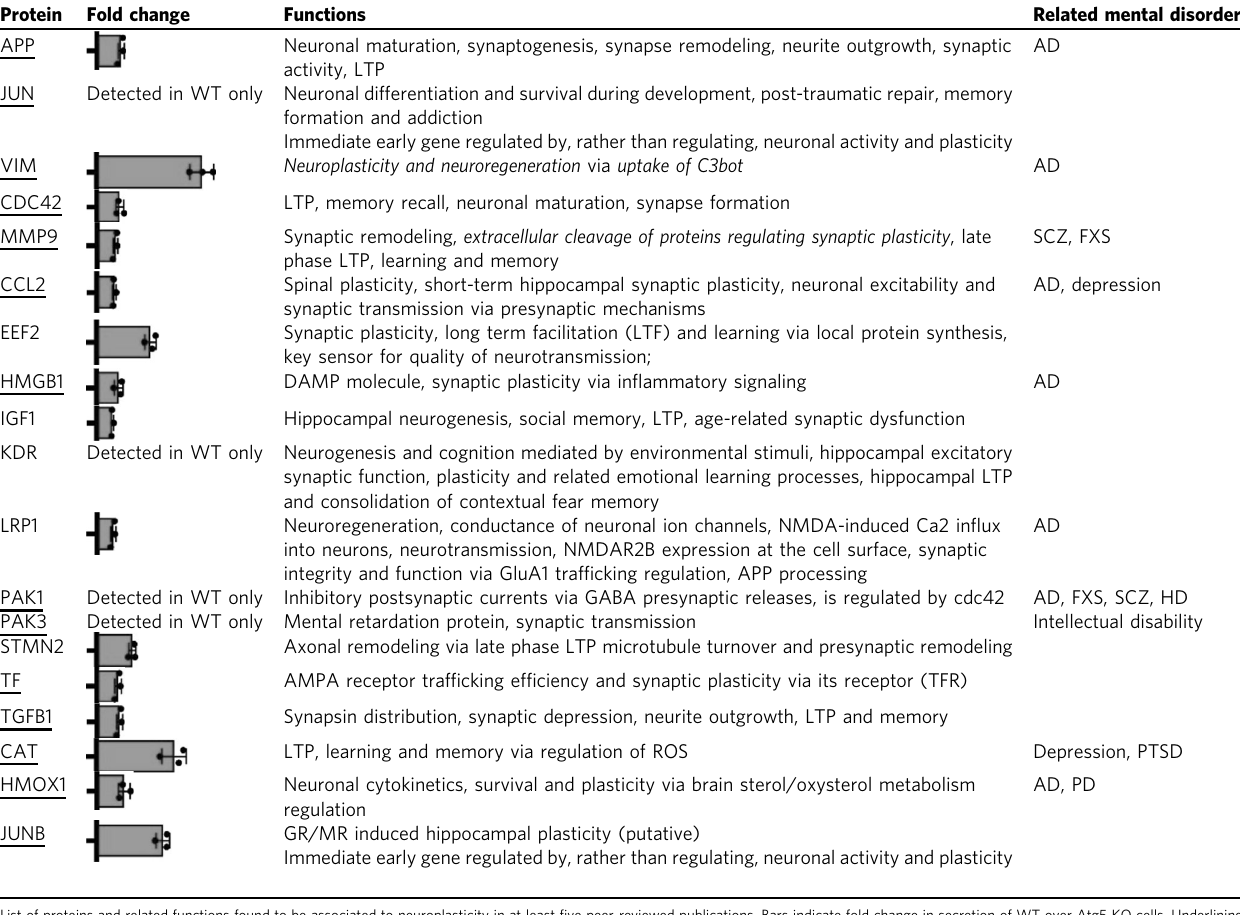
Table 1 Neuroplasticity-related proteins regulated by stress-induced secretory